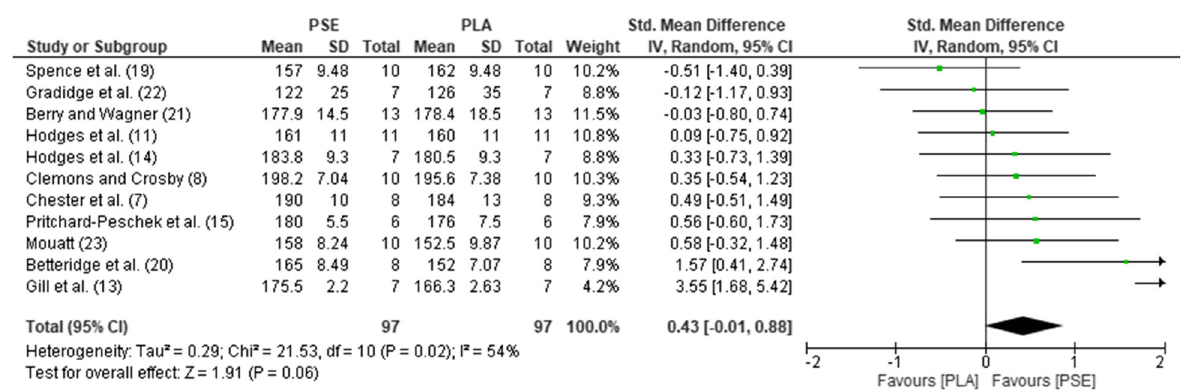
Fig. 2 Forest plot for effects of PSE on HR with 95% confidence intervals, HR, heart rate; PSE, pseudoephedrine; PLA, placebo; SD, standard deviation; Std., standardised; IV, instrumental variables; CI, confidence interval. Positive effect sizes represent an increase in HR due to